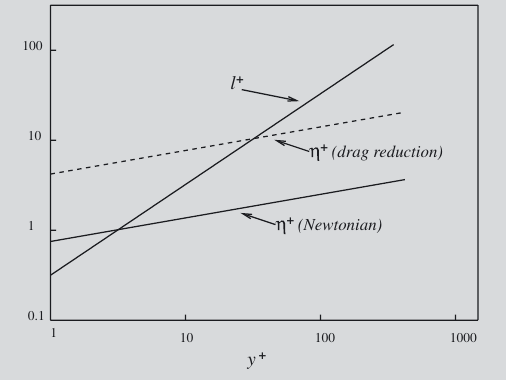
Figure 6: A schematic plot showing the spectrum of length scales in channel flow fol- lowing drag